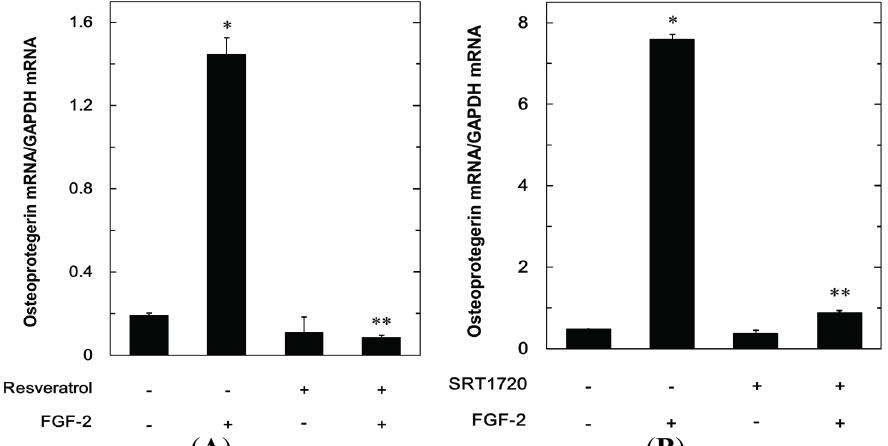
Figure 3. The effects of resveratrol or SRT1720 on the FGF-2-induced expression of osteoprotegerin mRNA in MC3T3-E1 cells. ( A ) The cultured cells were pretreated with 50 µM of resveratrol for 60 min or vehicle, and then stimulated by 30 ng/mL of FGF-2 or vehicle for 3 h; and ( B ) The cultured cells were pretreated with 10 µM of SRT1720 or vehicle for 60 min and then stimulated by 30 ng/mL of FGF-2 or vehicle for 6 h. The expression of osteoprotegerin mRNA and GAPDH mRNA was quantified by real-time RT-PCR. The osteoprotegerin mRNA levels were normalized to those of GAPDH mRNA. Each value represents the mean ± SEM of triplicate determinations from three independent cell preparations. * p < 0.05 compared to the value of control. ** p < 0.05 compared to the value of FGF-2